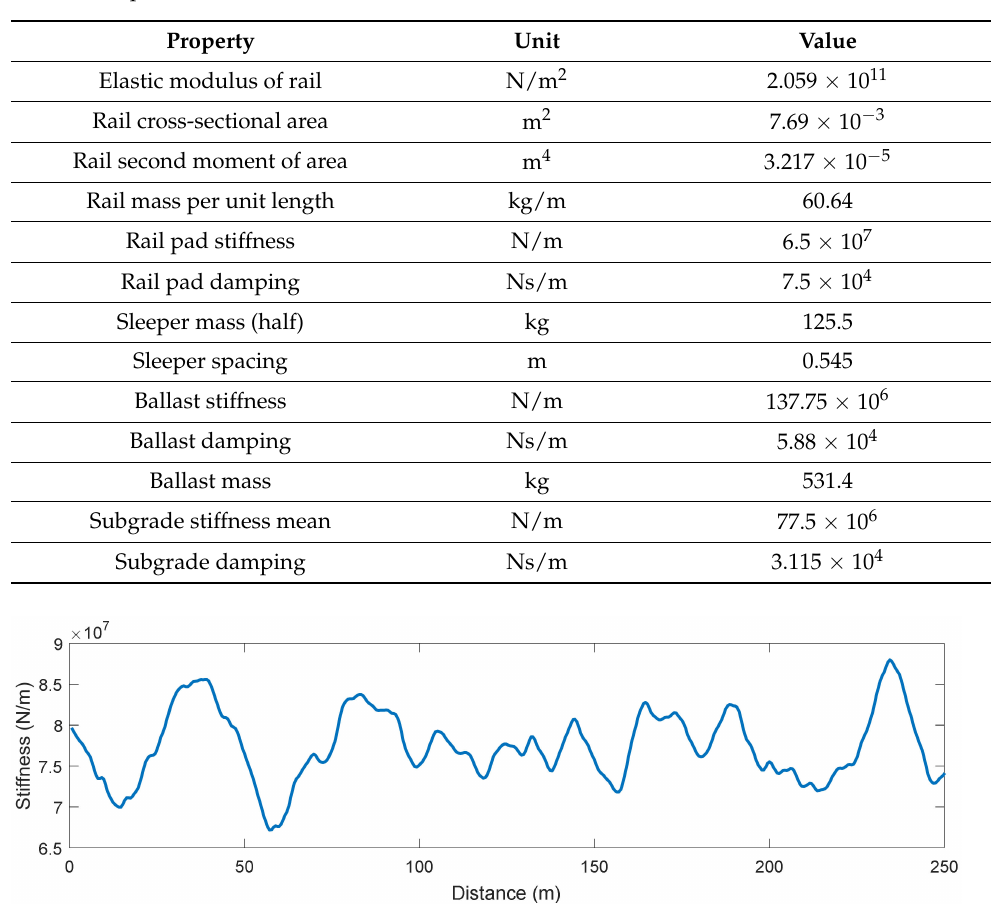
Figure 2. Track model. Table 1. Properties of the track.